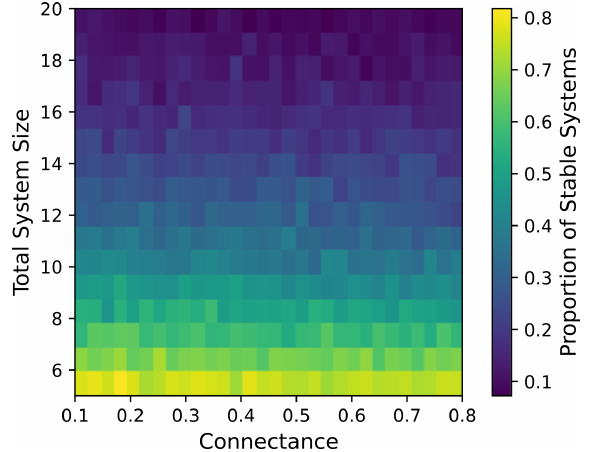
Figure 3. Effect of system size (number of actors and decision cen- ters) and connectance on stability. The color represents the propor- tion of stable systems (out of 600 samples) for each connectance and system size. The connectance shown here is the proportion of links between decision centers and resource users’ extraction or ac- cess ( G 1 , 1 and G 1 , 2 in Fig. 1); the same result holds for the total connectance as well (see Fig. S2 in the Supplement).